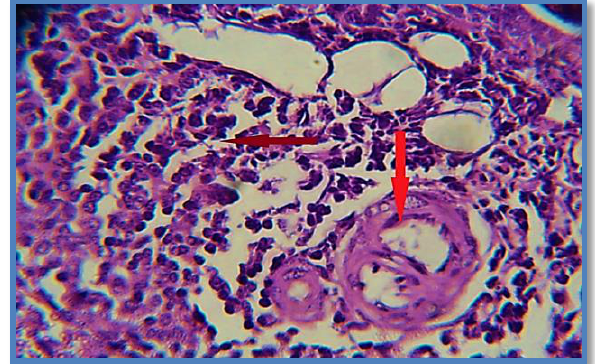
Figure, 13: Micrograph of goat group B mononucular cells infiltration in the incision area (red arrow) and fibrin deposition (yellow arrow) at 15 th day postoperative (H and E 10 X).